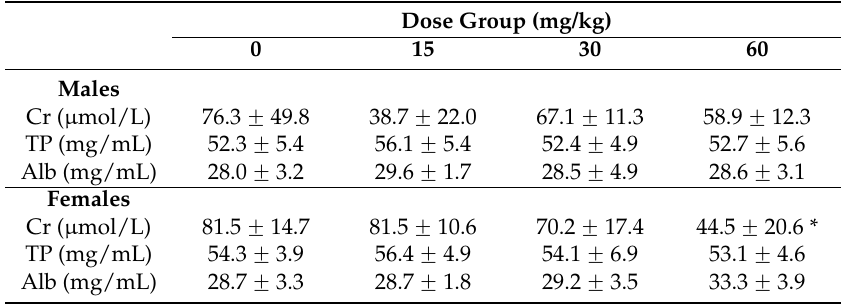
Table 6. Effects of SalB-Rg1 on biochemical parameters with a seven-day repeat dose. Dose Group